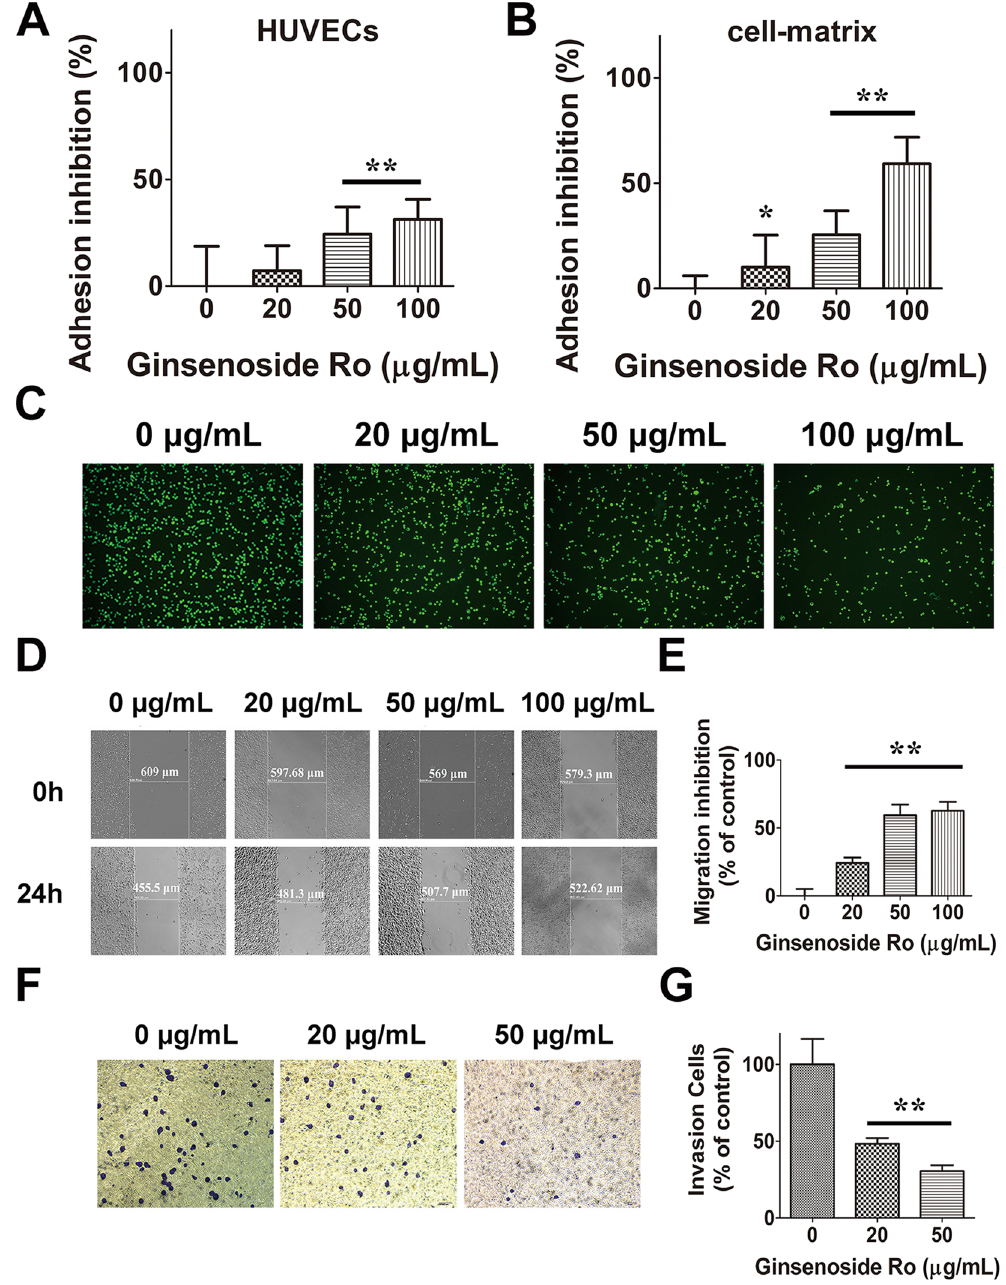
Figure 4. Ginsenoside Ro inhibited adhesion, migration and invasion of HT29 cells. ( A and B ) Ginsenoside Ro produced concentration-dependent inhibition of adhesion of HT29 cells to HUVECs ( A ), and matrigel ( B ); ( C ) Representative microscopic imaging showed concentration–dependent inhibition by ginsenoside Ro of adhesion of Rhodamine 123-labeled HT29 to HUVECs monolayers stimulated by IL-1 β (1 ng/mL). ( D ) and ( E ). Inhibition by ginsenoside Ro of HT29 mobility following the scratch assay: ( D ) inserted microscopic images taken at 0 and 24 h after the scratches; ( E ) quantitative analysis of concentration-dependent inhibition by ginsenoside Ro of HT29 migration on fibronectin. ( F ) Representative images (magnification × 200) showing that HT29 cells (blue) passed through the transwell monolayer, and the cell’s invasion ability was inhibited by ginsenoside Ro. ( G ) Quantitative analysis of the concentration-dependent inhibition by ginsenoside Ro of the HT29 invasion ability. The number of cells passing through the transwell monolayer was counted in five separate microscopic fields. Data represent the mean ± SD. (n = 3–5); ** P < 0.01, compared with the untreated